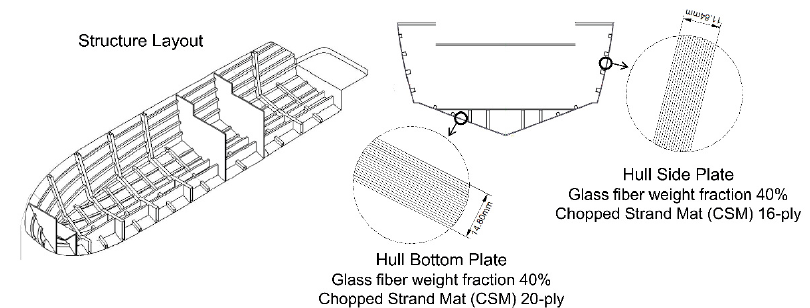
Figure 3. Details of the target ship structure and hull plate. Table 2. Material design for fabrication of two hull side plates.